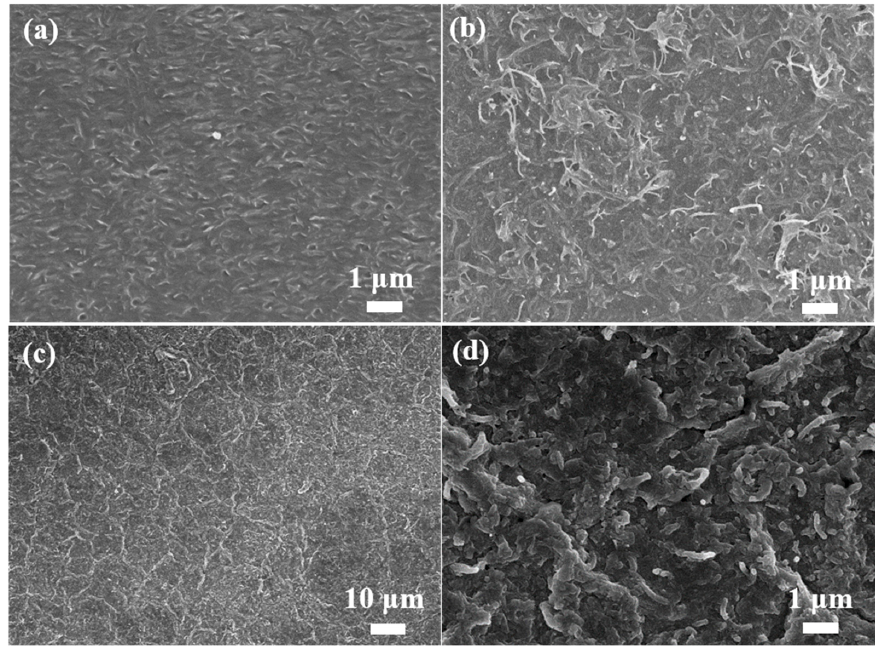
Figure 2. SEM images of the PDMS ( a ); MWCNTs-PDMS ( b ); PM2 films ( c , d ). The FT-IR patterns of the PANI/MWCNTs-PDMS films are shown in Figure 3a. The adsorption band at 3442 cm − 1 is designated as PANI N-H stretching vibrations. The peaks at 1558 and 1484 cm − 1 are attributed to the C=C stretching of the quinoid rings and the C- C stretching of the benzenoid rings of PANI, respectively. The materials exhibit charac- teristic peaks at 1295, 1239, 1138 and 790 cm − 1 , which correspond to the absorption of aro- matic amine, C-NH + stretching, the in-plane C-H bending vibration of the quinone ring and the C-H bending vibration of 1,4-disubstituted benzene. This indicates that PANI formed in the acid-doped state [26–28]. The weak absorption peaks at 1752, 1659 and 705 cm − 1 correspond to the symmetric stretching vibration of C=O, the -C=O- vibration and the deformation vibration of the acyl ring. These energy bands correspond to the CO-N- OC group, demonstrating that MWCNTs-COOH attached to PANI through covalent bonds [29–31]. The Raman spectra provide additional evidence for the growth of PANI along the MWCNTs. The MWCNTs/PDMS film exhibits two characteristic bands at 1588 and 1342 cm 2 , which are attributed to the high-frequency modes of the phonon (G mode) and the disorder-induced peak (D mode) (Figure S4). Moreover, the peaks at 490, 708, 2905 and 2965 cm − 1 are the characteristic peaks of PDMS films. With the addition of the content of PANI, the peaks of the MWCNTs are weakened, and the peaks of PANI are displayed. The peaks at 1598, 1496, 1321 and 1160 are attributed to the C-C bond in benzene, N-H deformation, C-N + bond stretching and the C-H bending of quinoid, respectively (Figure 3b) [27,32,33]. The synthesized films were cut to 1 × 1.5 cm 2 , and the I-V curves were tested, as shown in Figure 3c. The composite films exhibit an ohmic behavior in the [–2, +2 ] V range. Through a corresponding fitting with a power law of I = AU^n, the n values of the films are 0.0012, 1.38, 1.06 and 1.09. The result shows that the n value of the PM2 films is closer to 1. The MWCNTs/PDMS films have poor electrical conductivity, and PANI is a conducting polymer that can impart high electrical conductivity to the material. As the PANI content increases, the electrical conductivity of the films also increases. Further- more, the PM2 film has better conductivity, which makes the electron mobility faster, and the delocalization effect of the material on polarons becomes stronger [34–36].